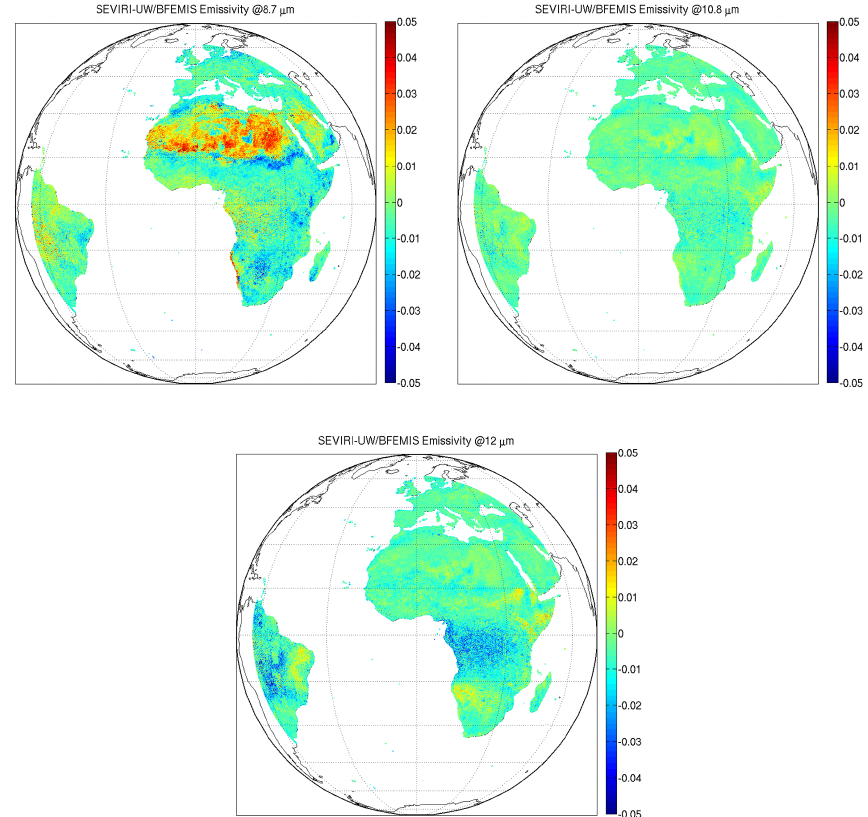
Figure 22. November 2007. Full-disk emissivity difference map (SEVIRI–UW/BFEMIS) for the channels at 8.7µm (top left), 10.8µm (top right) and 12µm (bottom).